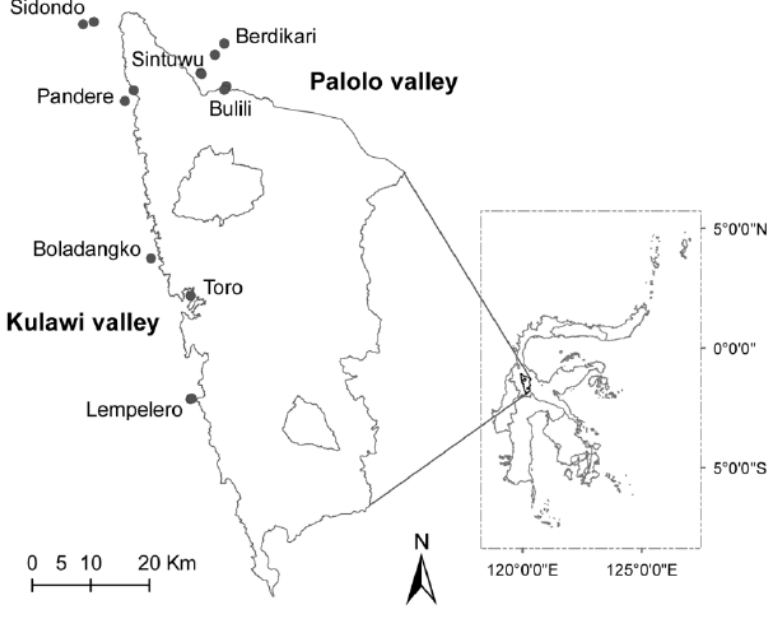
Figure 1. Location map of the 16 cacao agroforestry plots in eight villages with different precipitation levels. Villages are located around Lore Lindu National Park, Central Sulawesi, Indonesia.